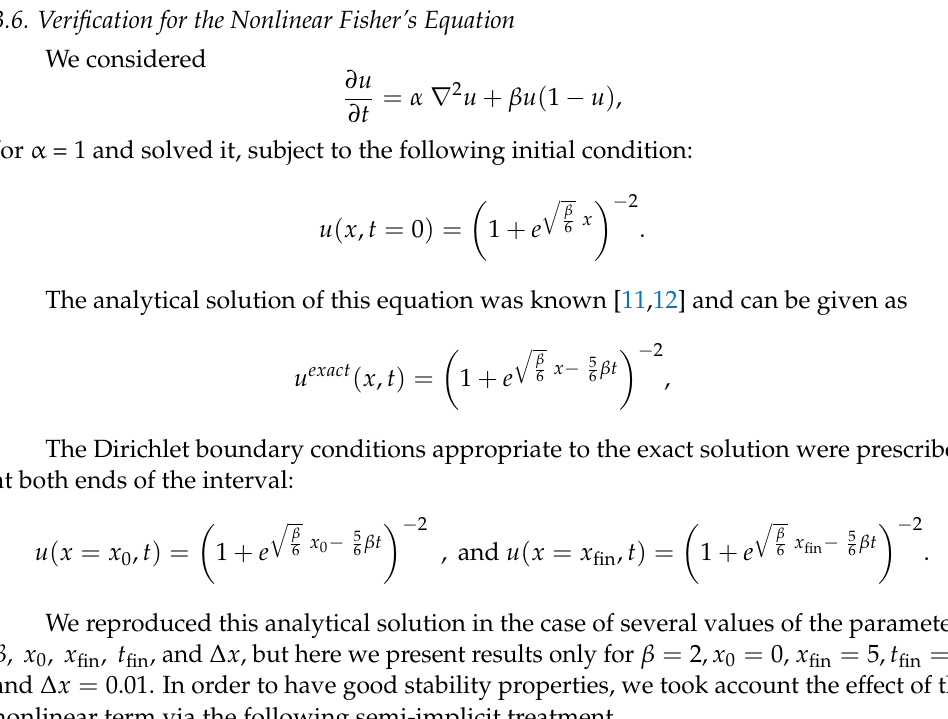
Figure 9. The graphs of the second solution, where u 0 is the initial function u 2 ( x , t 0 ) and uref is the analytical solution at the final time, while S3 and S5 are the corresponding numerical solutions served by the S3 (¼, ½, ½, ½, ¾) and the S5 (0, ½, ½, C, 1) algorithms for